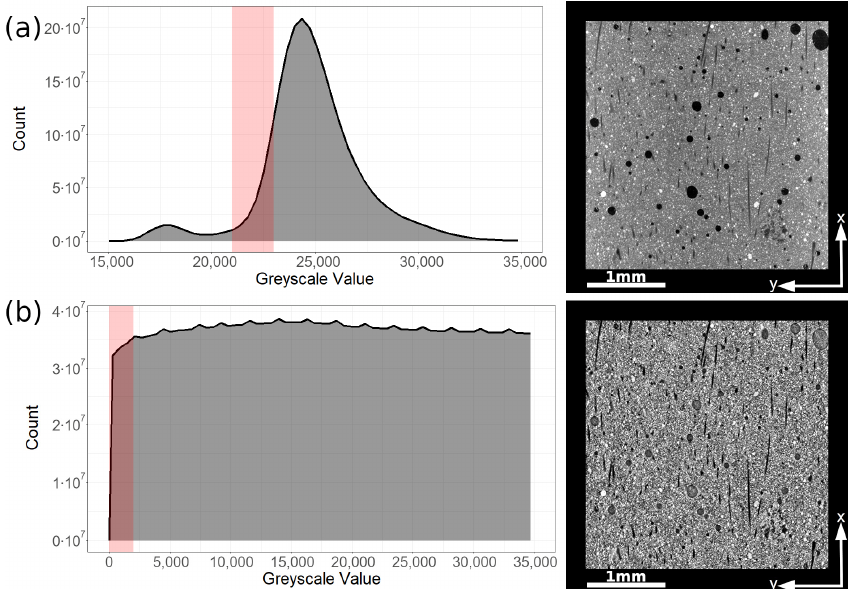
Figure 1. ( a ) Original, unfiltered scan. Fibers vary in grayscale value and overlap with the matrix, making clean segmentation difficult. ( b ) Scan after being filtered through an LHE filter. Fibers appear as monochromatic black with considerably improved contrast to the matrix. The areas marked in red depict the approximate grayscale values corresponding to carbon fibers.